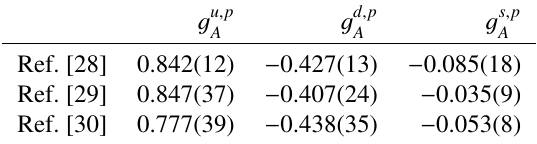
Table 1. Axial-vector charges of the nucleon, from lattice QCD [29, 30] and phenomenology